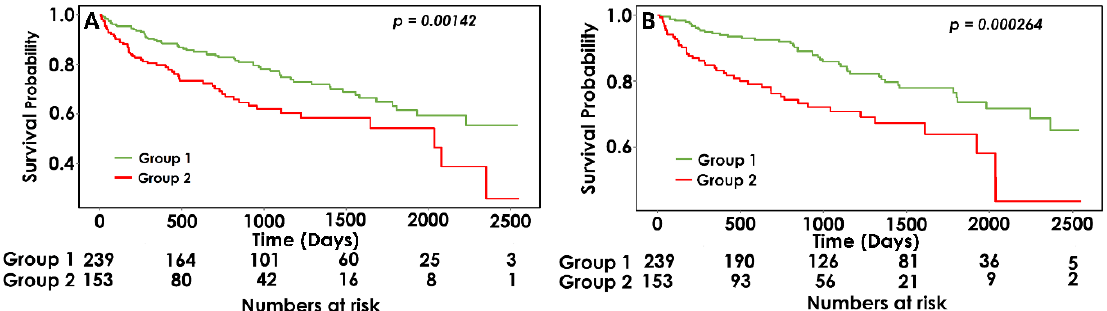
Figure 2. Kaplan–Meier analysis for ( A ) major adverse cardiovascular event (MACE); ( B ) all-cause mortality according to the total carotid plaque number (TPN). Table 2. Unadjusted and adjusted hazard ratio for MACE and all-cause mortality according to the total carotid number of plaque MACE All-Cause Mortality Multivariate Univariate Analysis Univariate Analysis Multivariate Analysis Analysis